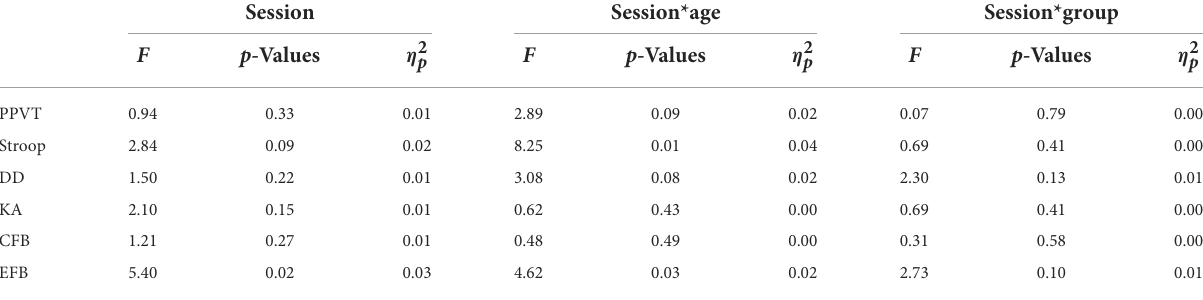
TABLE 4 Full statistics for the 2 (intervention group vs. active reading control group) × 2 (session: pre vs. posttest) factorial ANOVAs.